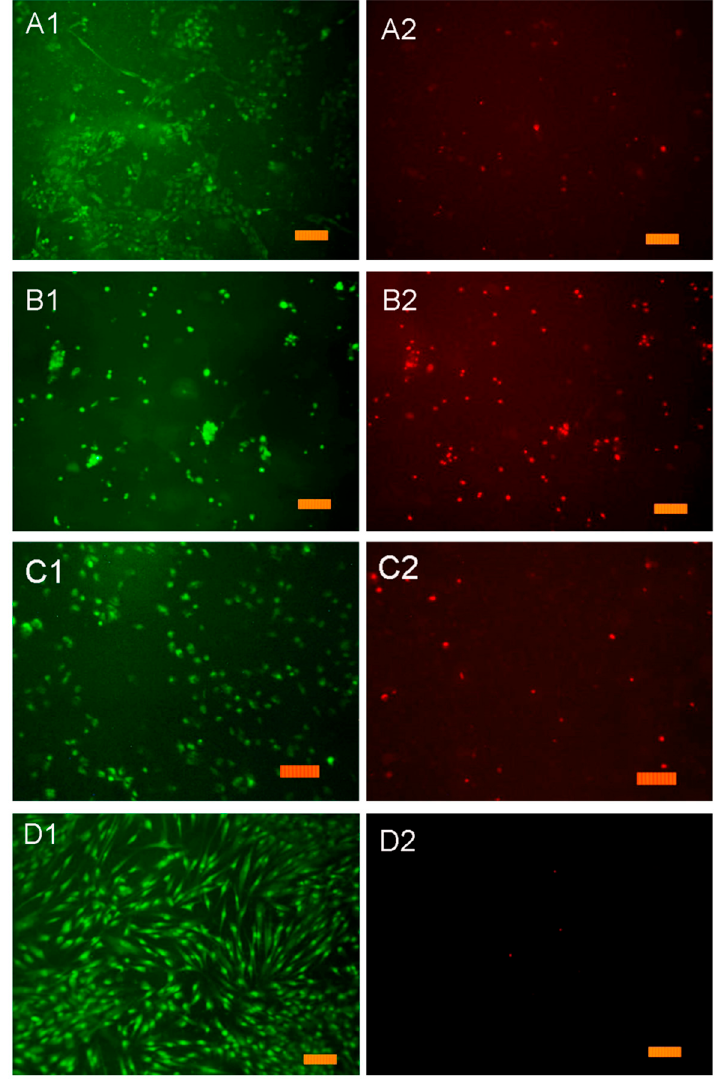
Figure 12. Resazurin test. DPSCs cultured for 24 h on the surface of composite film samples: ( A1 , A2 )— sample 6; ( B1 , B2 )—sample 7; ( C1 , C2 )—sample 8; ( D1 , D2 )—control sample and glass slide. The label corresponds to 100 µ